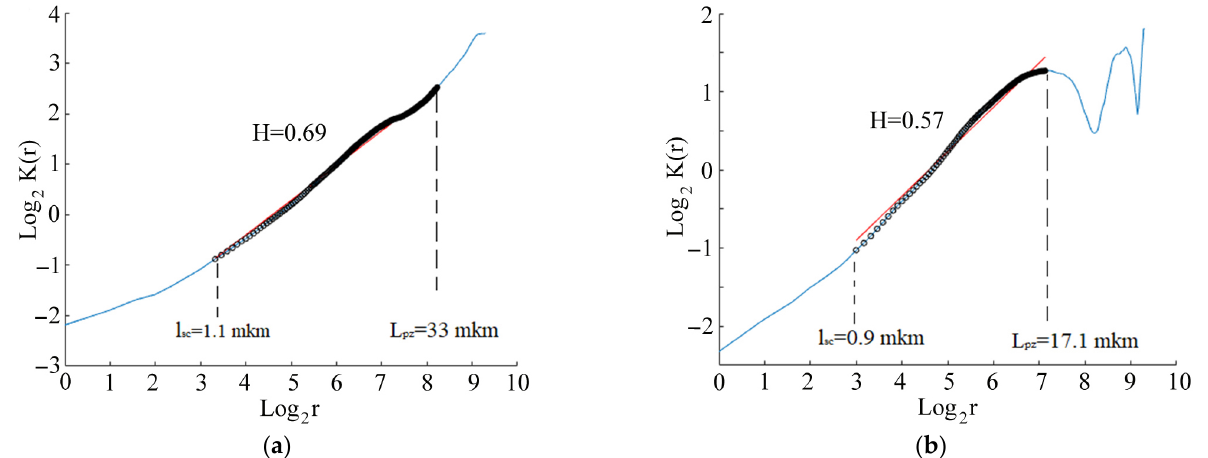
Figure 16. log 2 K(r) as a function of log 2 (r), Hurst exponent coefficient H and scales L pz and l sc of the CG Ti45Nb alloy sample for different zones: ( a ) zone 1; ( b ) zone 2.